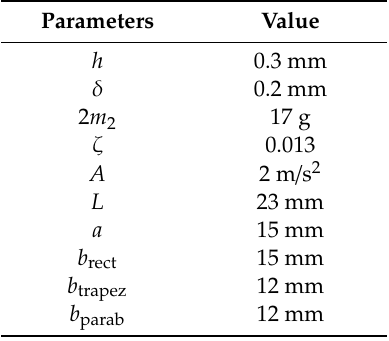
Table 2. Geometric Table 2. Geometric parameters.